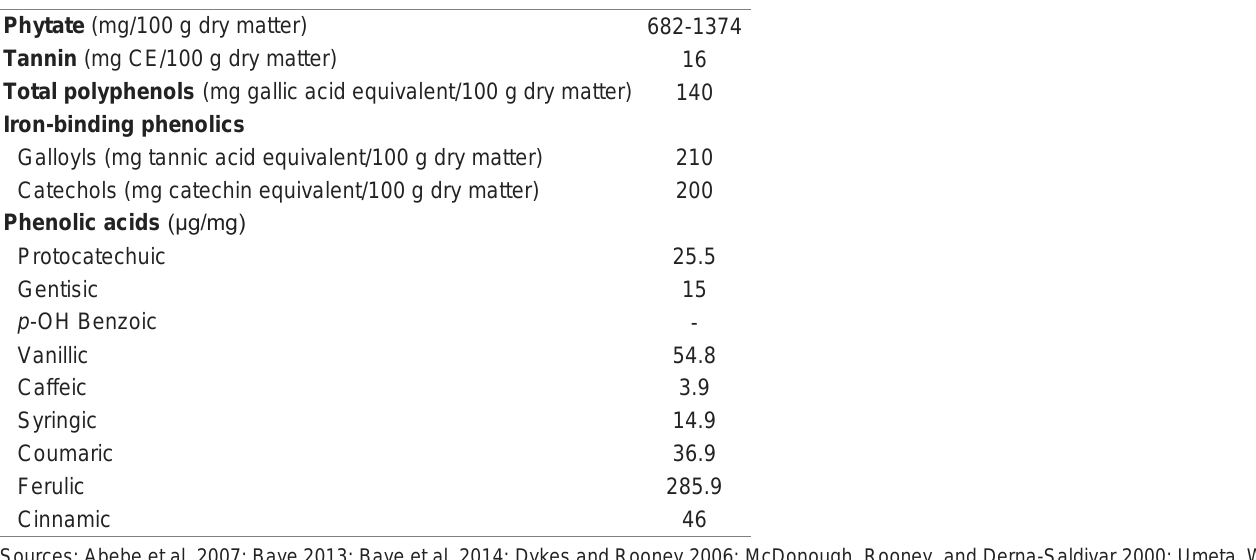
Table 3.3 — Phytochemical composition of teff